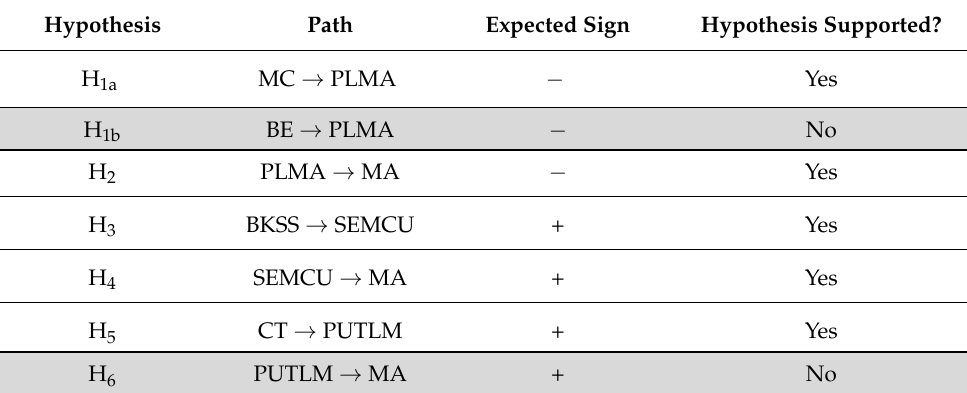
Table 2. Summary of hypotheses testing for structural model: pre-pandemic approach